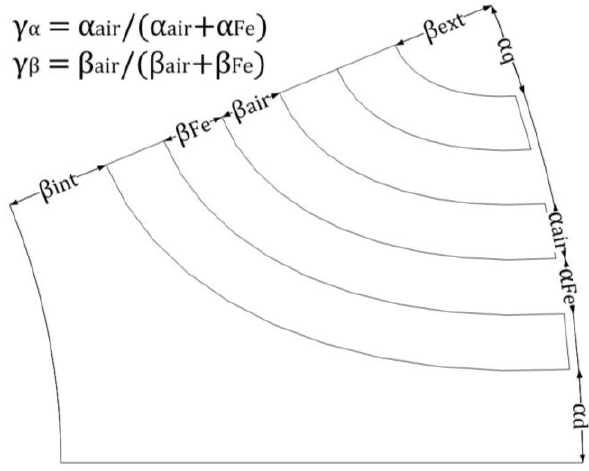
Figure 2. Elliptic-shaped barrier rotor geometry.